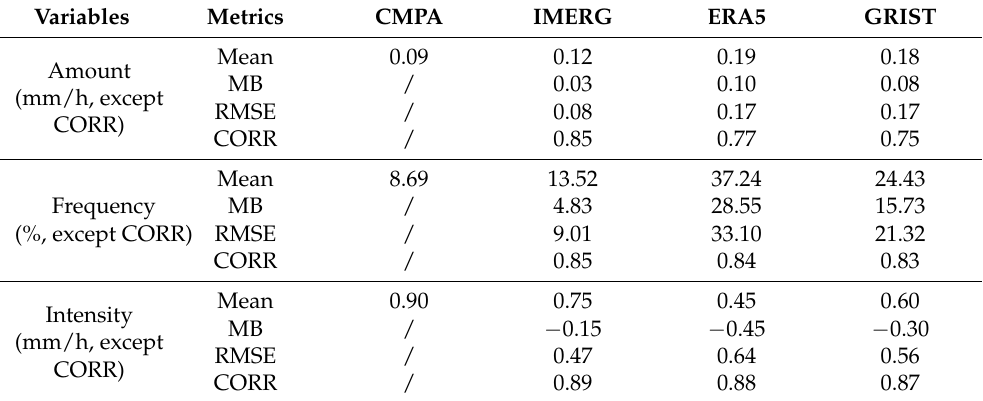
Table 3. Statistical error metrics of precipitation derived from IMERG, ERA5, and GRIST versus CMPA at the grids’ elevation levels higher than 2000 m for the study